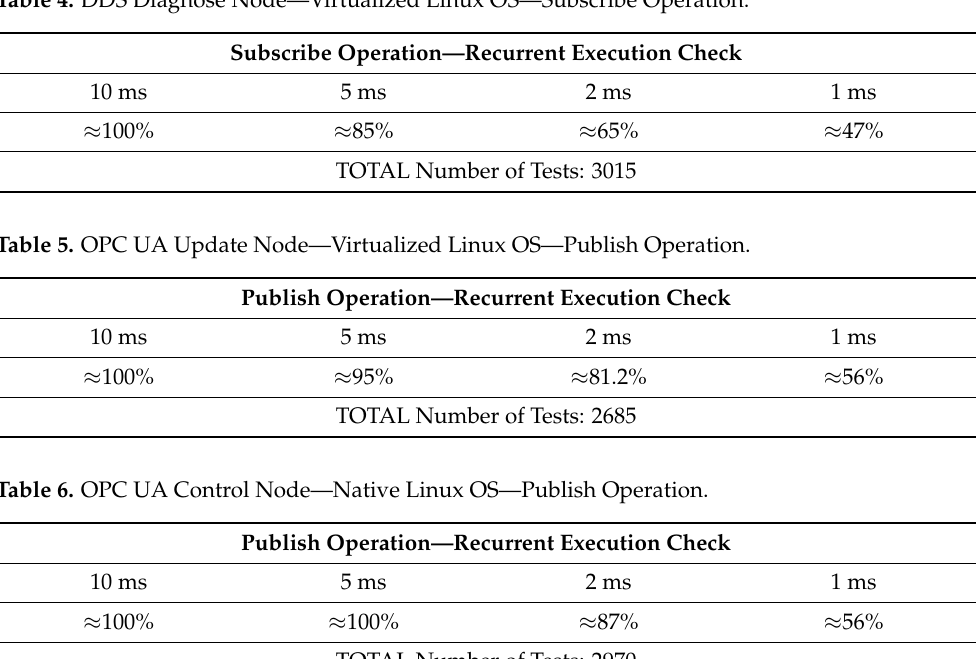
Table 4. DDS Diagnose Node—Virtualized Linux OS—Subscribe Operation.